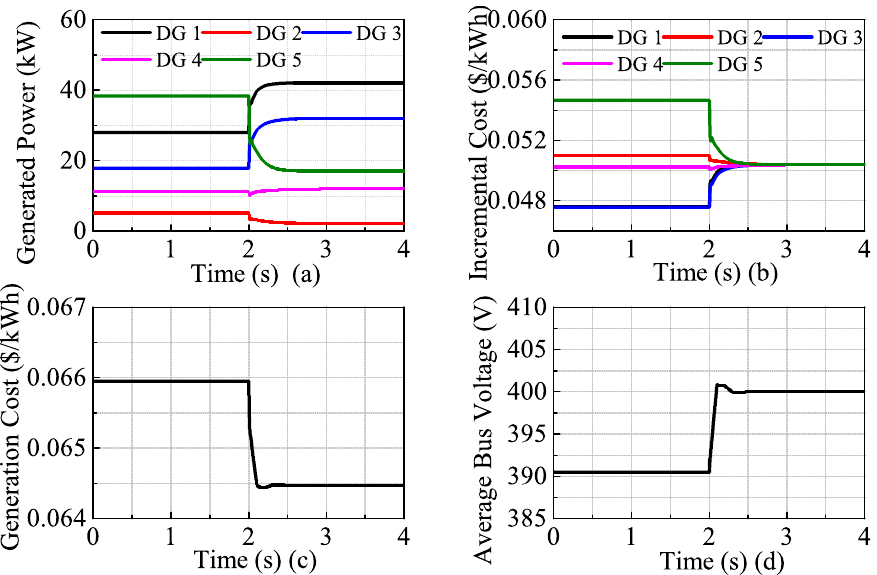
Figure 10. Comparative studies of a DC microgrid before and after the proposed control strategy was applied. ( a ) Generated power of each DG. ( b ) Incremental cost of each DG. ( c ) Total generation cost of all the DGs. ( d ) Average bus voltage of the microgrid.